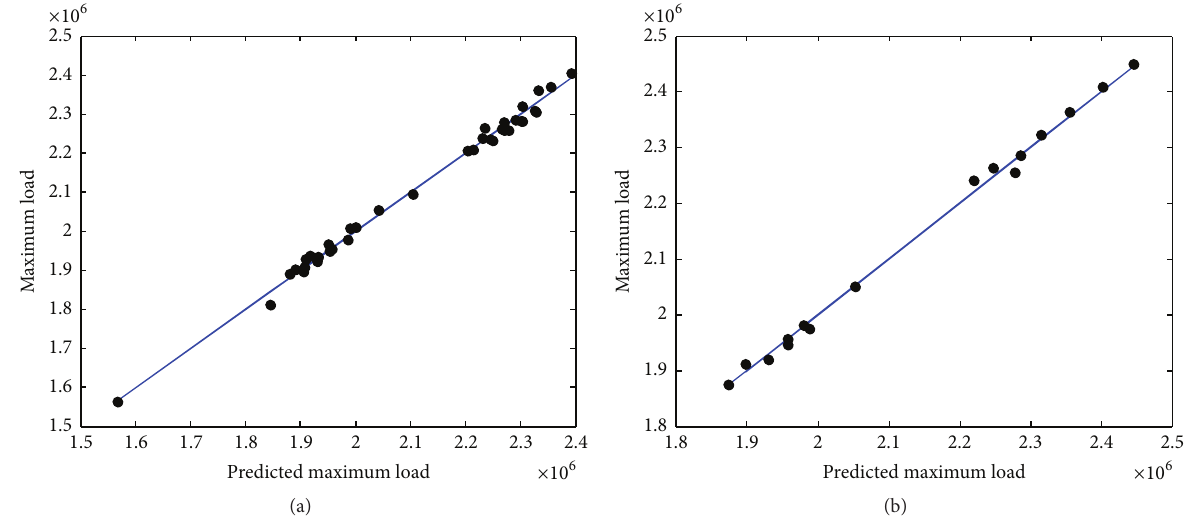
Figure 4: Regression diagrams of real and predicted results (using network) for (a) training data set and (b) testing data set: maximum